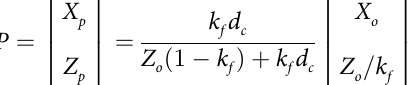
Fig 9. Effect of distance mismatches. (a) screen distance is smaller than convergence distance ( k d = 0.33), and (b) screen distance is larger than convergence distance ( k original world ( E ; D ) and dashed lines represent the eccentricity-disparity in the reconstructed world ( E oc o